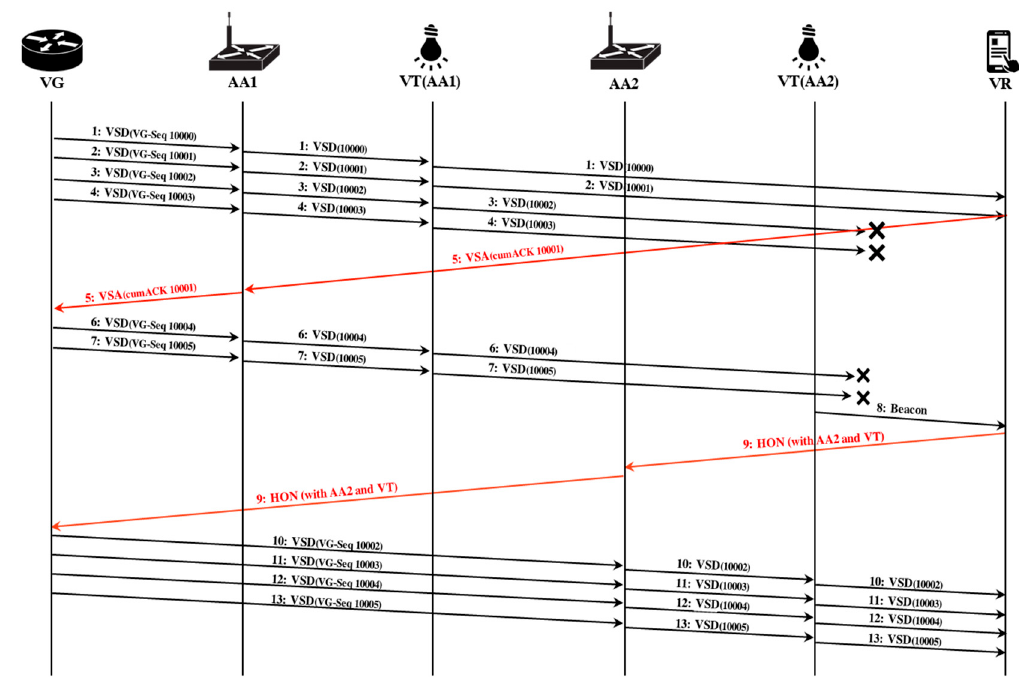
Figure 16. AA handover operations.